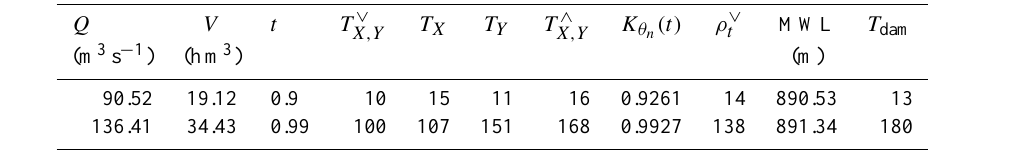
Table 8. Example of comparison among return periods. Two simulated events with a copula value of 0.9 and 0.99 are considered. All return periods are expressed in years.